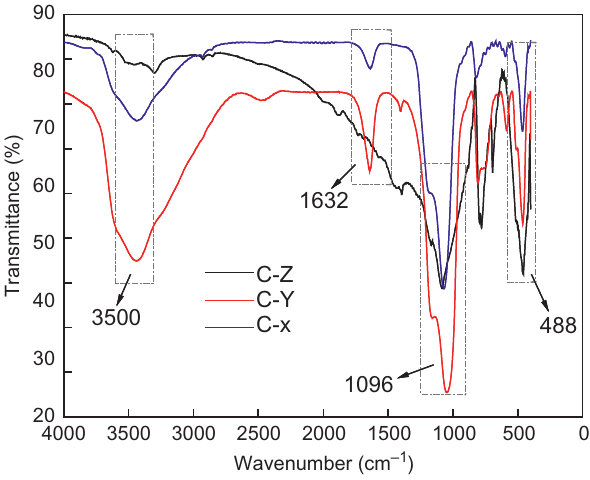
Figure 1: IR-spectra patterns of C-X, C-Y, and C-Z.